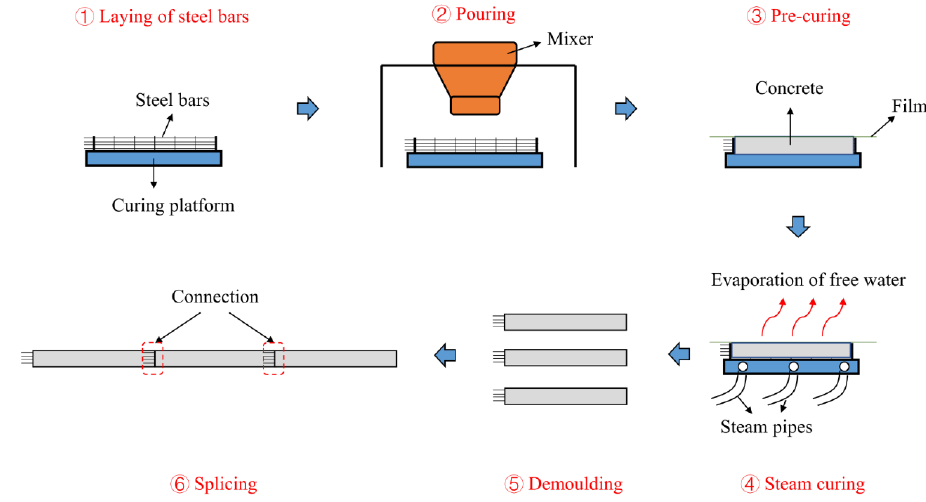
Figure 1. The production and application of PC.